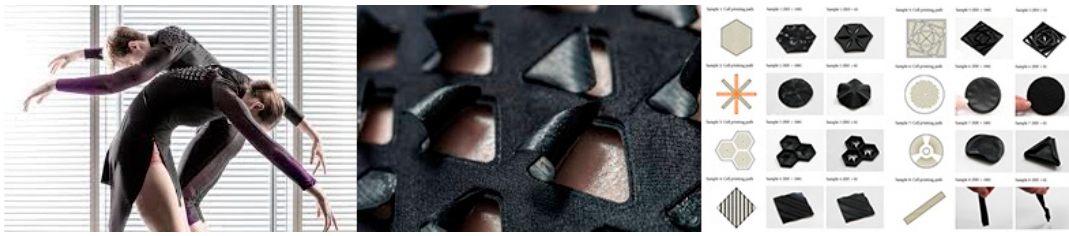
Figure 3. BioLogic . Courtesy MIT Tangible Media Group Lab.